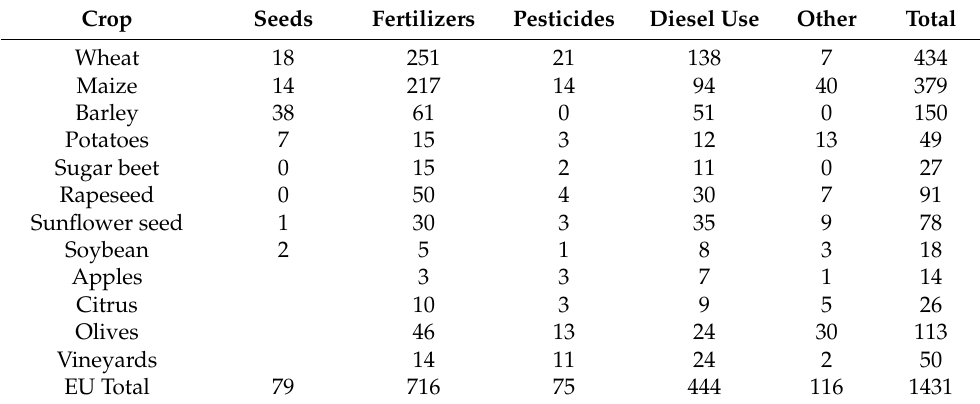
Table 1. Total energy inputs for selected open-field crops EU-27 (in PJ). Crop Seeds